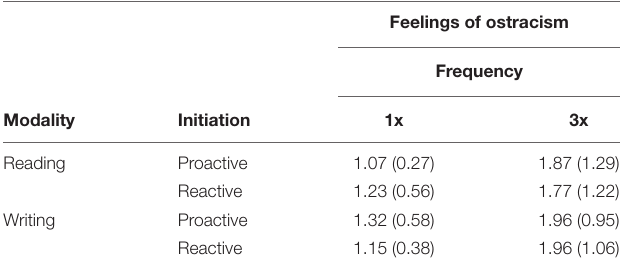
TABLE 5 | Mean feelings of ostracism (SDs in parentheses) as a function of modality of phubbing (reading vs. writing), initiation of phubbing (proactive vs. reactive), and phubbing frequency.